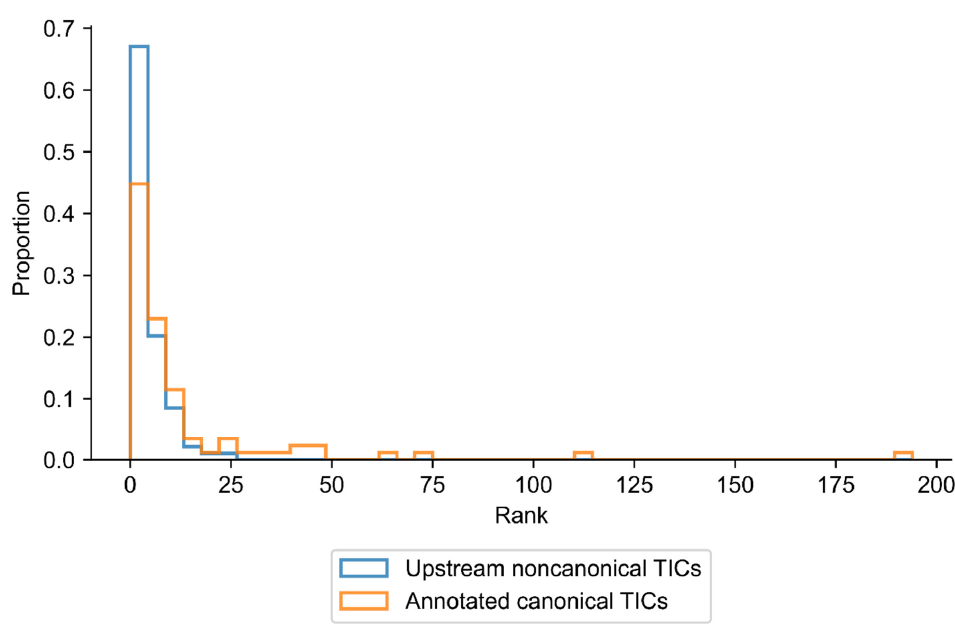
Figure 3. Rank of TICs in genes associated with